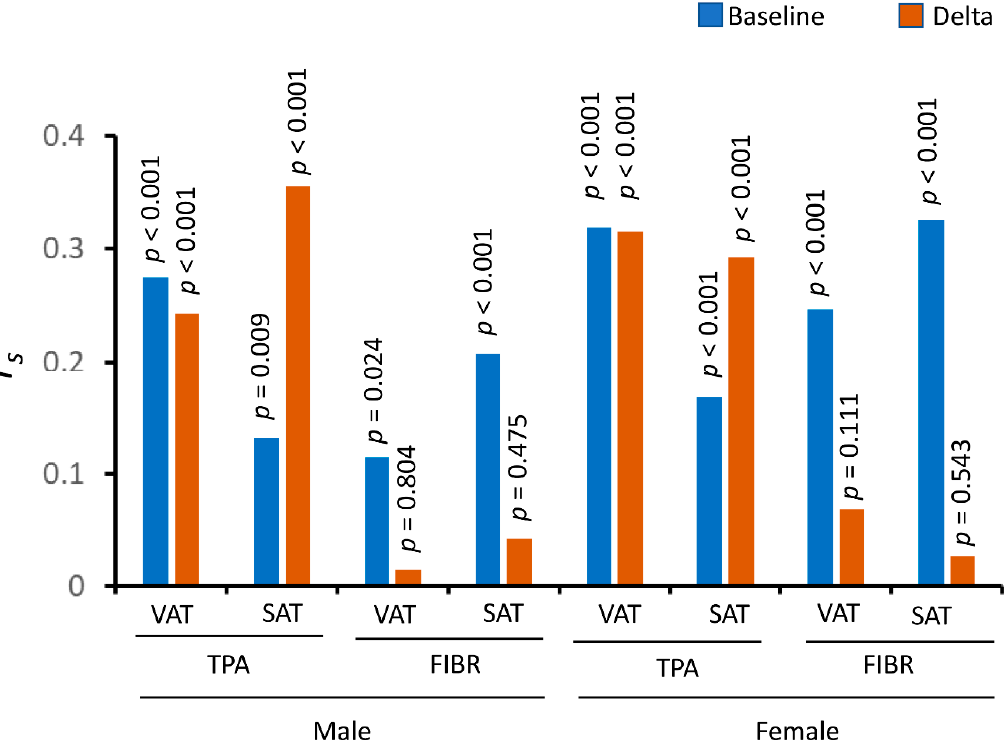
Figure 5. Correlation coefficients and p -values for the correlations between adiposity and levels of TPA and FIBR. TPA and